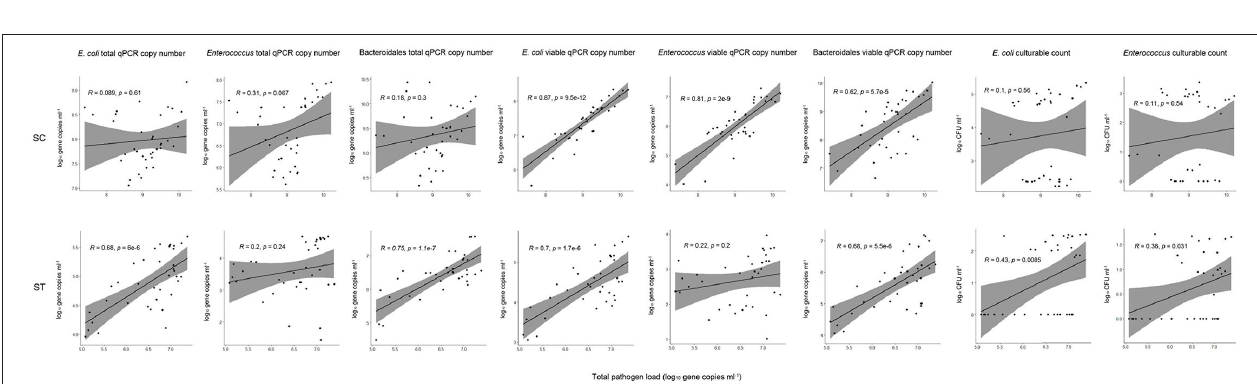
FIGURE 4 | The average concentrations of total and viable pathogenic species before and after chlorine disinfection in each sewage treatment work over the year. Color scale represented the Z-scores in rows. Paired t- test for comparing the concentrations of species in all PMA-treated samples before and after chlorine disinfection: * p < 0.05, ** p < 0.01, *** p < 0.001.